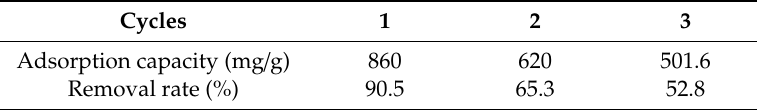
Table 7. The regeneration property of